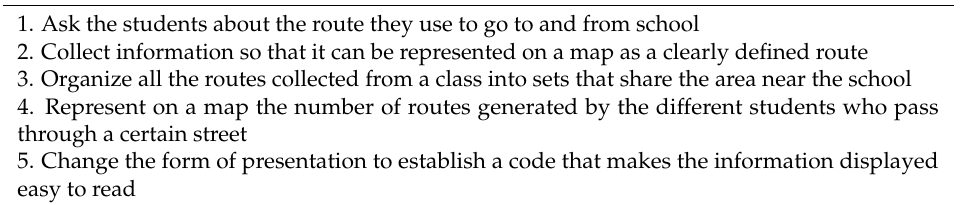
Table 1. Description of the modeling process used to generate a map of route use intensity in terms of identified